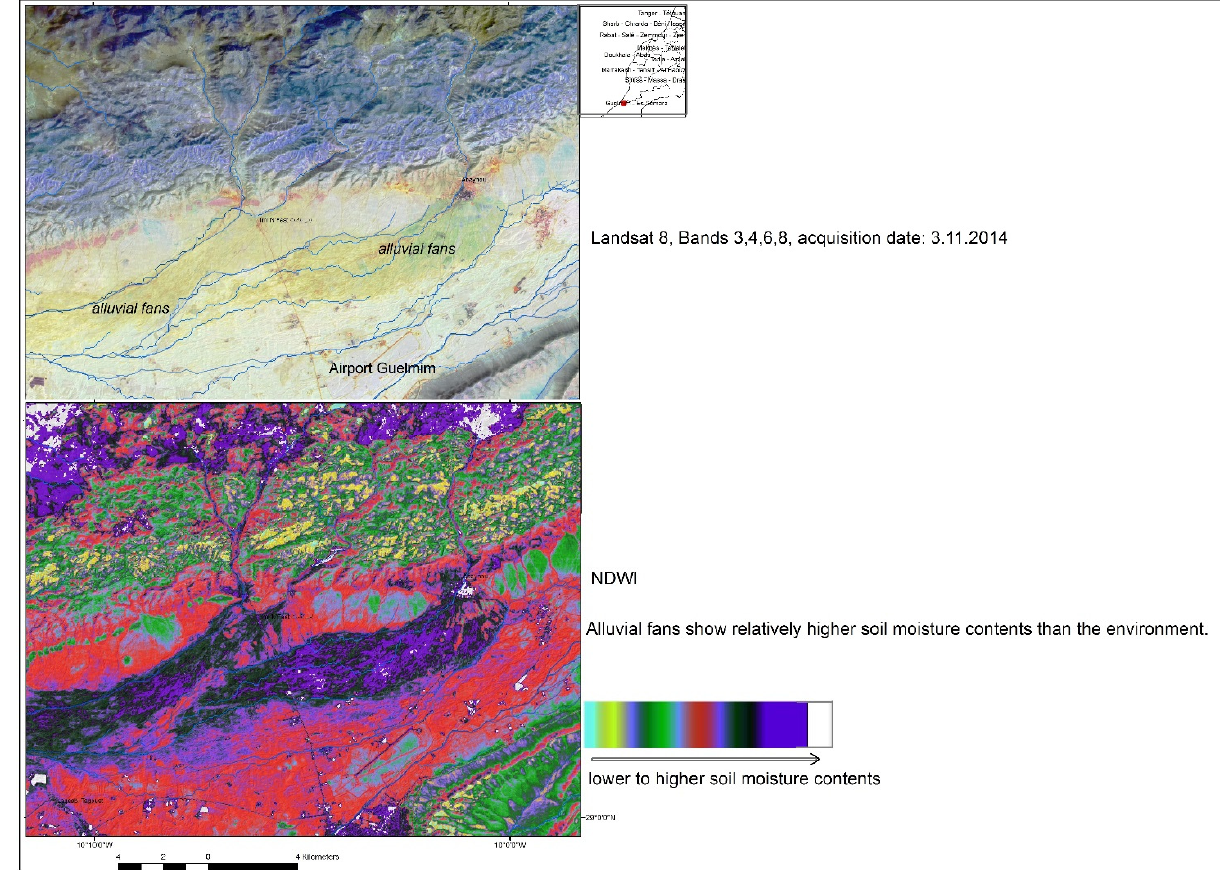
Figure 8. Landsat 8 images (3 November 2014) visualizing areas with relatively higher soil moisture using NDWI calculations using Landsat 8 bands 5 and 7 (water surfaces are presented in white, and higher soil moisture or vegetation-water content in